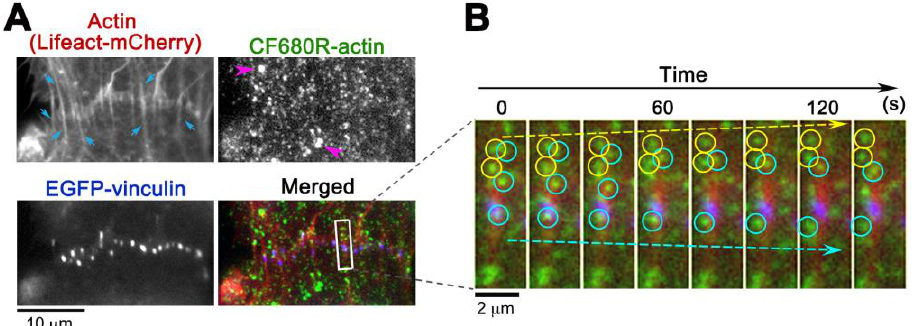
Figure 4. Observation of CF680R-actin SiMS in actin bundles at cell-to-cell boundaries of XTC cells. ( A ) CF680R-actin co-assembles to actin bundles (blue arrows) visualized by Lifeact-mCherry. The actin bundles are originated from punctate adherens junctions marked by EGFP-vinculin. Pink arrowheads in the CF680R-actin image indicate fluorescent organelle-like structures, which is apparently an artifact of electroporation; ( B ) Time-lapse images paneled at 20 s intervals in the area (rectangle) are shown on the right. Actin bundle-associated CF680R-actin SiMS moving upward (yellow arrow) and downward (blue arrow) are indicated by yellow (upward) or blue (downward) circles. Time-lapse images of CF680R-actin SiMS (green) are overlaid with the static images of Lifeact-mCherry (red) and EGFP-vinculin (blue).